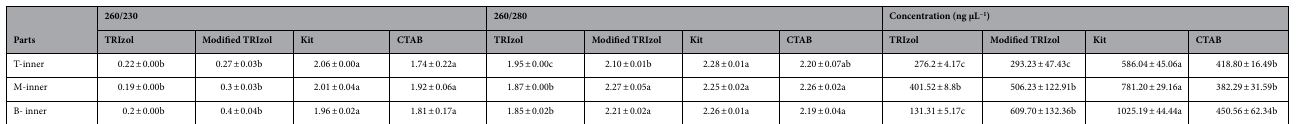
Table 2. Average purity and yield of total RNA extracted from inner scales of Lilium davidii var. unicolor using different methods. T The top part of the detected scales, M The middle part of the detected scales, B The basal part of the detected